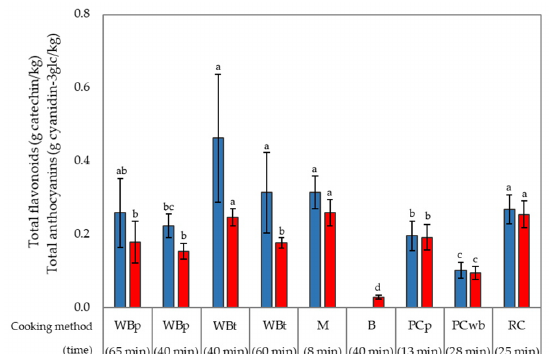
Figure 3. Effect of different cooking methods on total flavonoids (blue) and total anthocyanins (red) for Venere rice (sample 12). Legend: WBp, water bath on plate; WBt, water bath on thermostatic bath; M, microwave; B, boiling; PCp, pressure cooker pilaf method; PCwb, pressure cooker with water bath method; RC, rice cooker. Different letters mean significant differences ( p < 0.05). The contents of total flavonoids and total anthocyanins in raw rice sample were 5.36 ± 0.49 g catechin/g rice and 2.28 ± 0.15 g cyanidin 3- O -glucoside/g; these were significantly different.